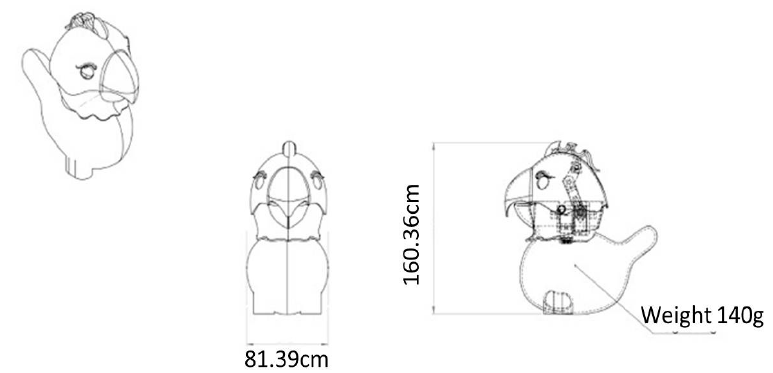
Figure 4 . Wearable KiliRo robot’s schematic diagram.